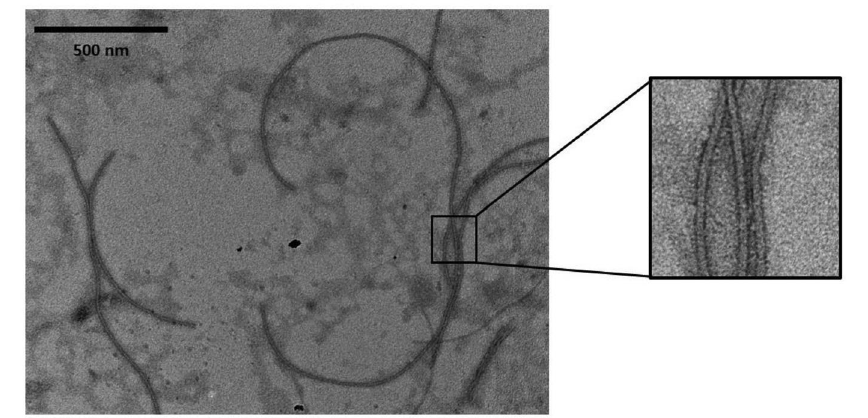
Fig. 1. TEM image of chitin fibres extracted from Amantia muscaria .